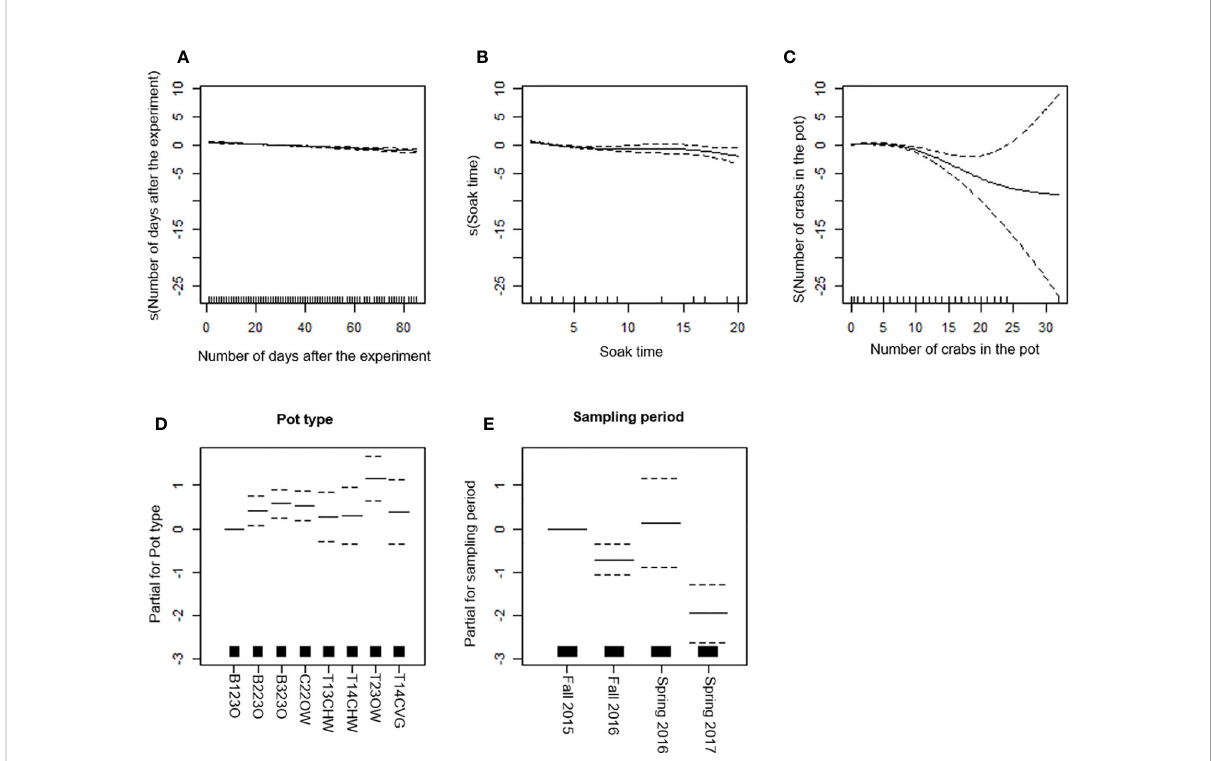
FIGURE 3 Generalized additive model (GAM) partial dependence plots for European lobster. (A-C) Partial response curves: the x-axis represents the value of the model independent variable whereas the y-axis represents the additive contribution of the variable to the nonparametric GAM smoothing function. Values below zero indicate a negative effect of the variable on the CPUE. (D, E) Partial effects of pot type and sampling period on the CPUE. The dotted line (A – E) represents the 95% con fi dence interval. The black lines on the x-axis represents sample